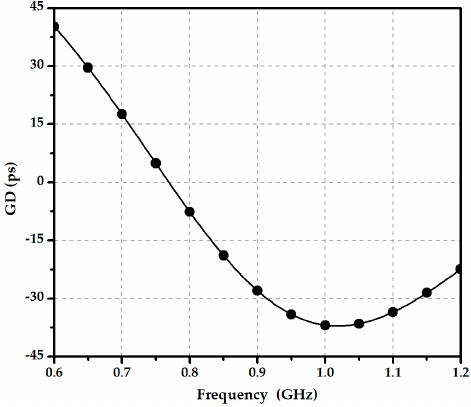
Figure 5. GD (group delay) generated by the input matching circuit.